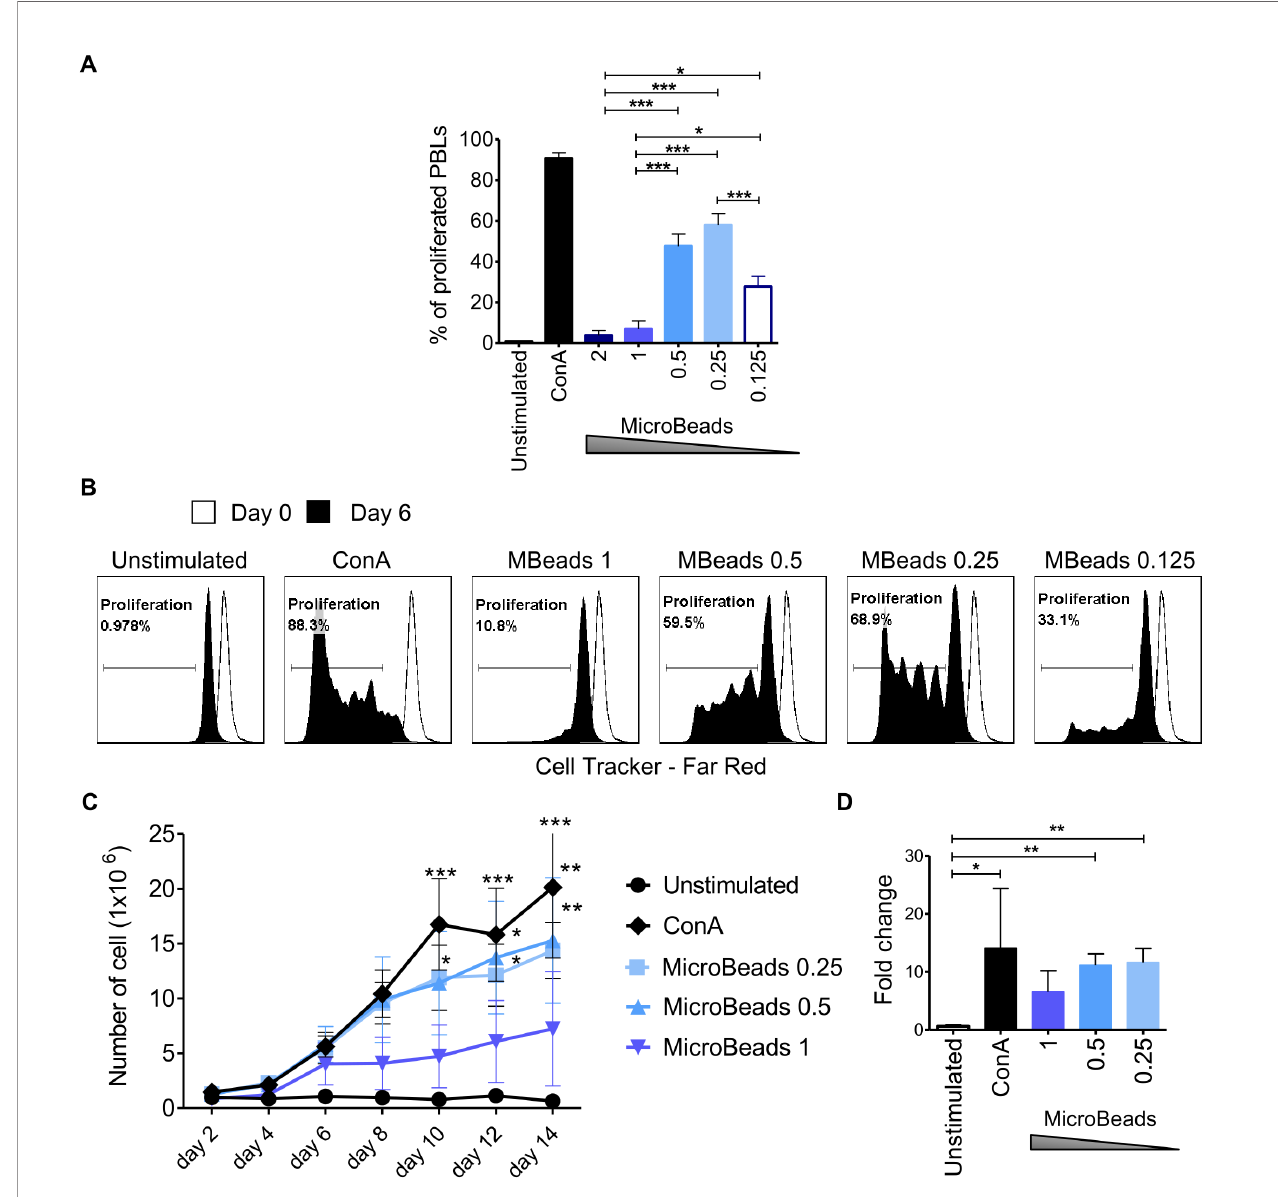
FIGURE 4 | Activation signal strength affects proliferation and expansion rate of canine lymphocyte. (A) Quanti fi cation of the percentage of canine PBLs proliferation under different activation conditions (T cell to MicroBead ratios as indicated) on day 6 of culture. Data are shown as the mean of three dogs (n=3), and error bars indicate SEM. Statistical analysis was performed by One-way analysis of variance (ANOVA) with Tukey ’ s Multiple Comparison Test. (B) Representative histograms of PBLs stained with CellTrace ™ Far Red, cultured with different Microbeads concentrations on day 6 of culture (FASC Aria II, Becton Dickinson). Histograms indicating the multiple peaks at successive generations of cPBLs divisions are shown. (C) Expansion kinetic for canine PBLs cultured using different activation signal strength provided by Microbeads and ConA. Data are shown as the mean of four dogs (n=4), and error bars indicate SEM. The number of viable cells was determining every other day for 14 days total using Countess II Automated Cell Counter and 4% Trypan blue. Statistical analysis was performed by Two-way RM ANOVA test (* p < 0.05, ** p < 0.01, *** p < 0.001). (D) Bar graph showing fold change of cPBLs number upon activation with ConA and different T cell to MicroBead ratios (as indicated) on day 14 of the culture. Data are shown as the mean of four dogs (n=4), and error bars indicate SEM. Statistical analysis was performed by